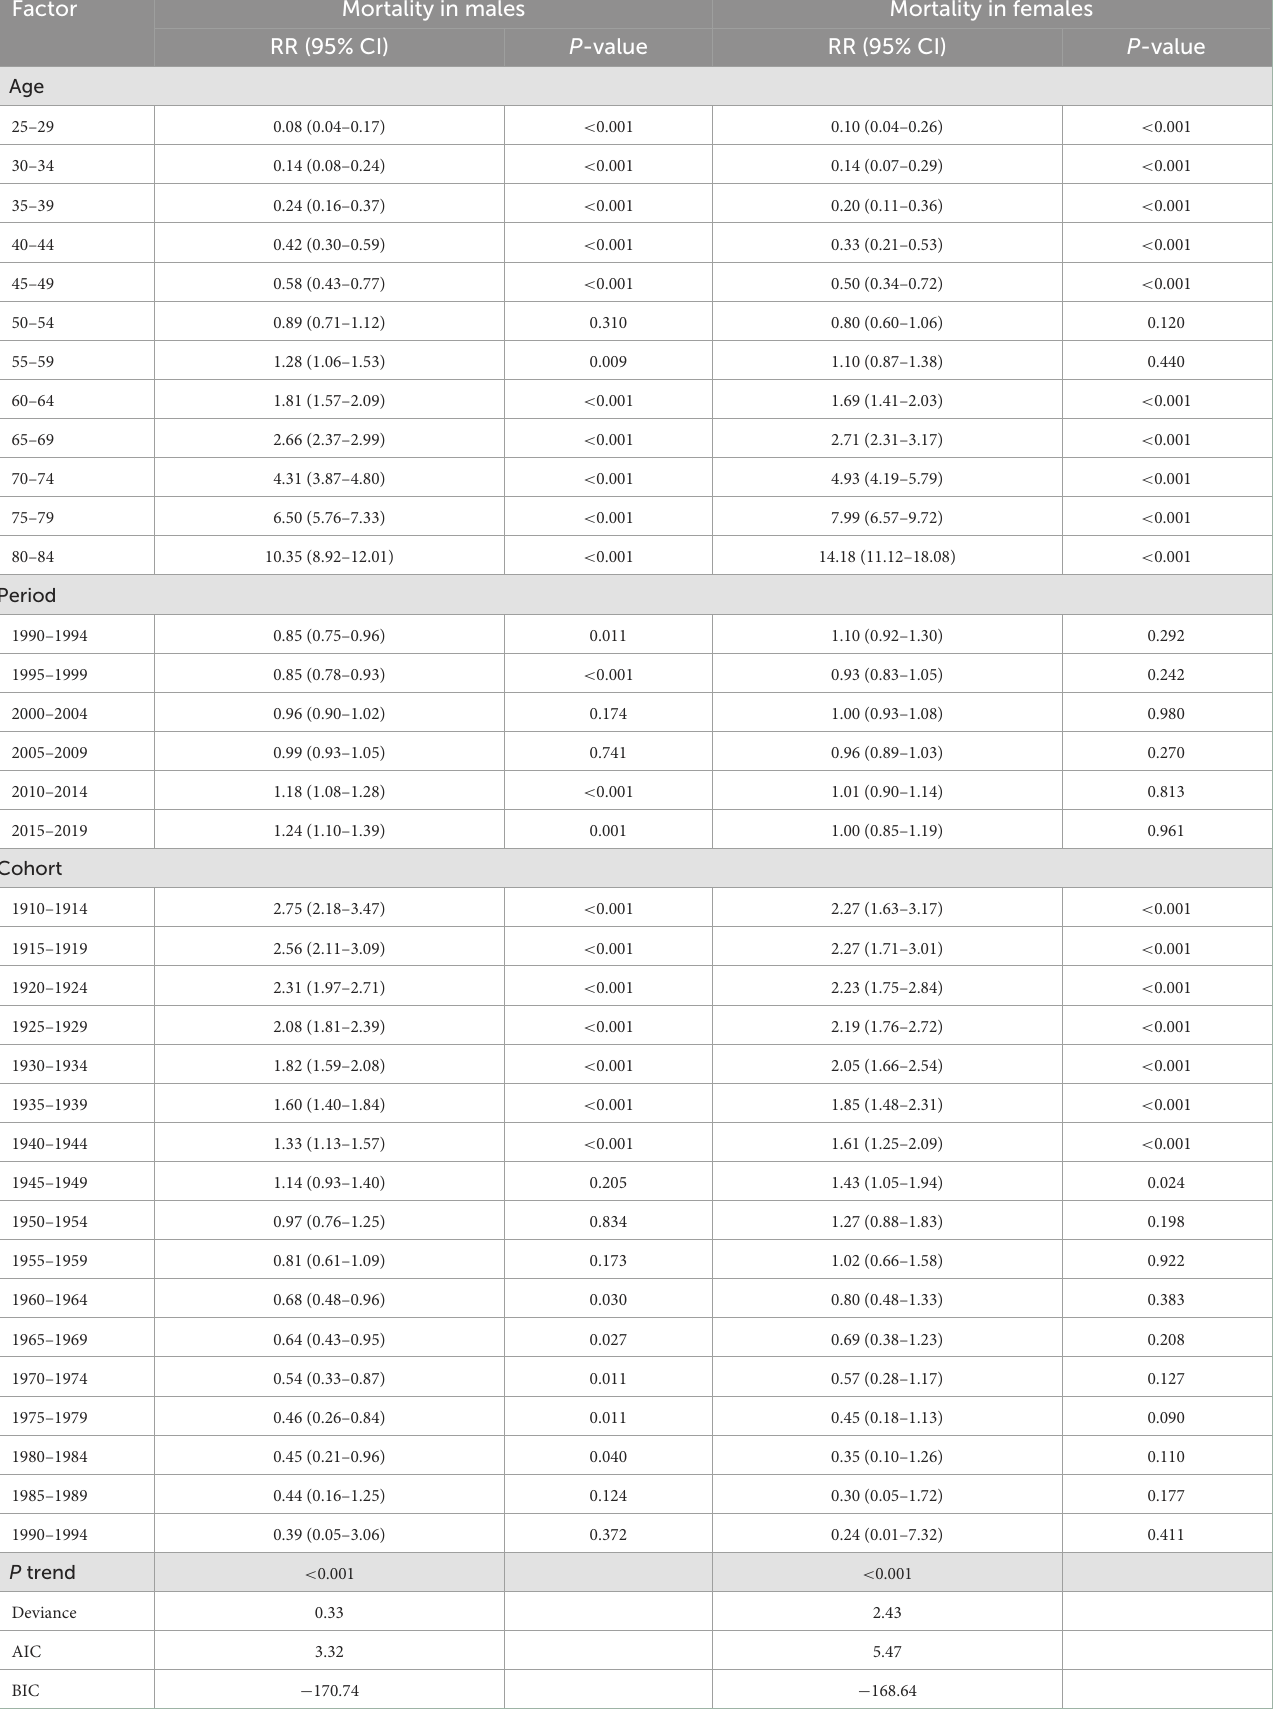
TABLE 2 Sex-specific relative risks of CVD death attributable to non-optimal temperatures in China due to age, period, and cohort effects.